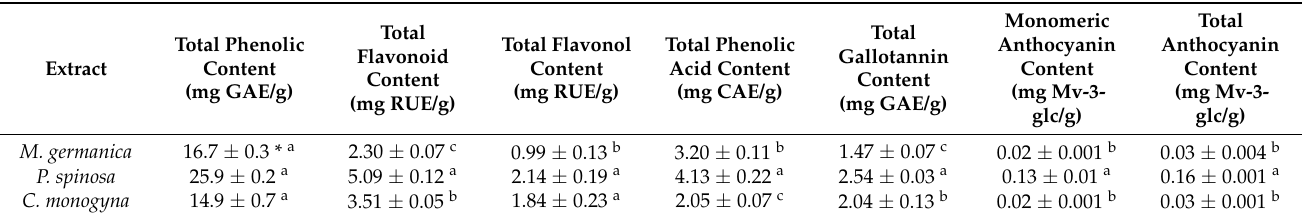
Table 1. Phenolic compounds content in M. germanica , P. spinosa and C. monogyna fruit ethanolic extracts.